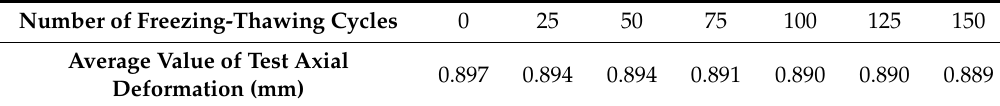
Table 2. Axial deformation of concrete specimens under di ff erent freeze–thaw cycles. Number of Freezing-Thawing